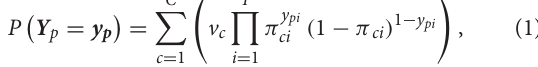
. Table 2 provides a sample of a measure with three attributes: the first item that measures one attribute only (i.e., α 1 ) has two estimates, where the third item which